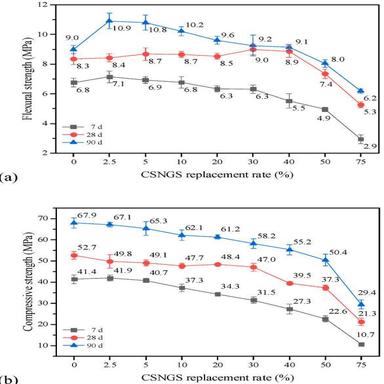
(a) Flexural strength and (b) compressive strength of mortars with different curing ages.